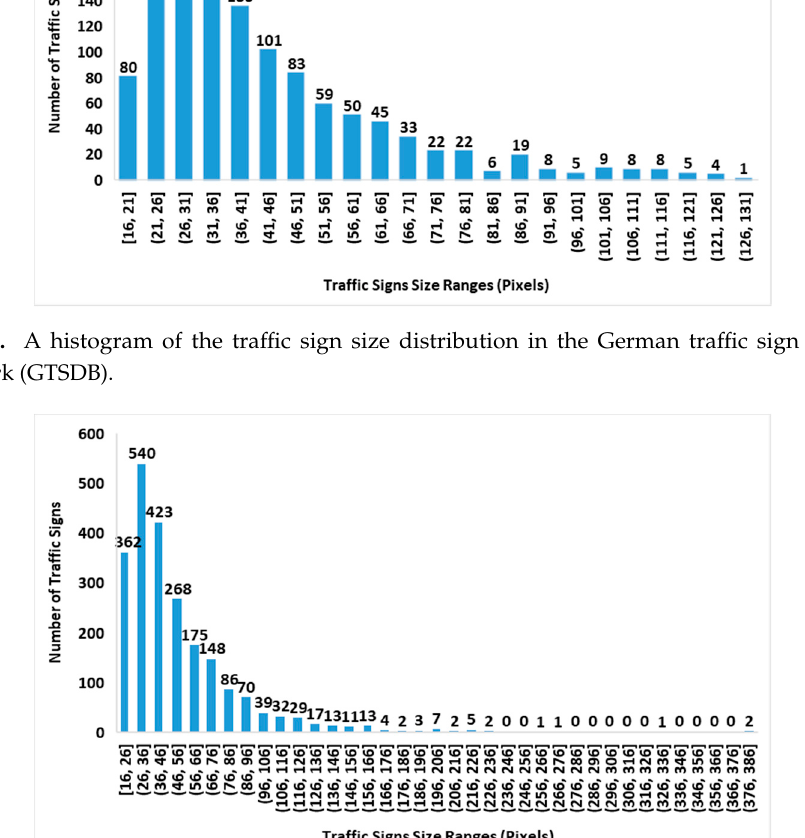
Figure 14. A histogram of the traffic sign size distribution in the joint GTSDB and CTSD dataset.